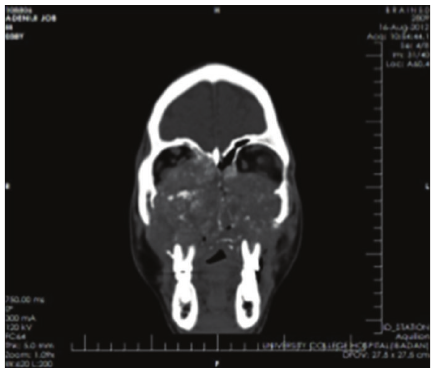
Figure 5: Coronal CT showing maxillary and orbital